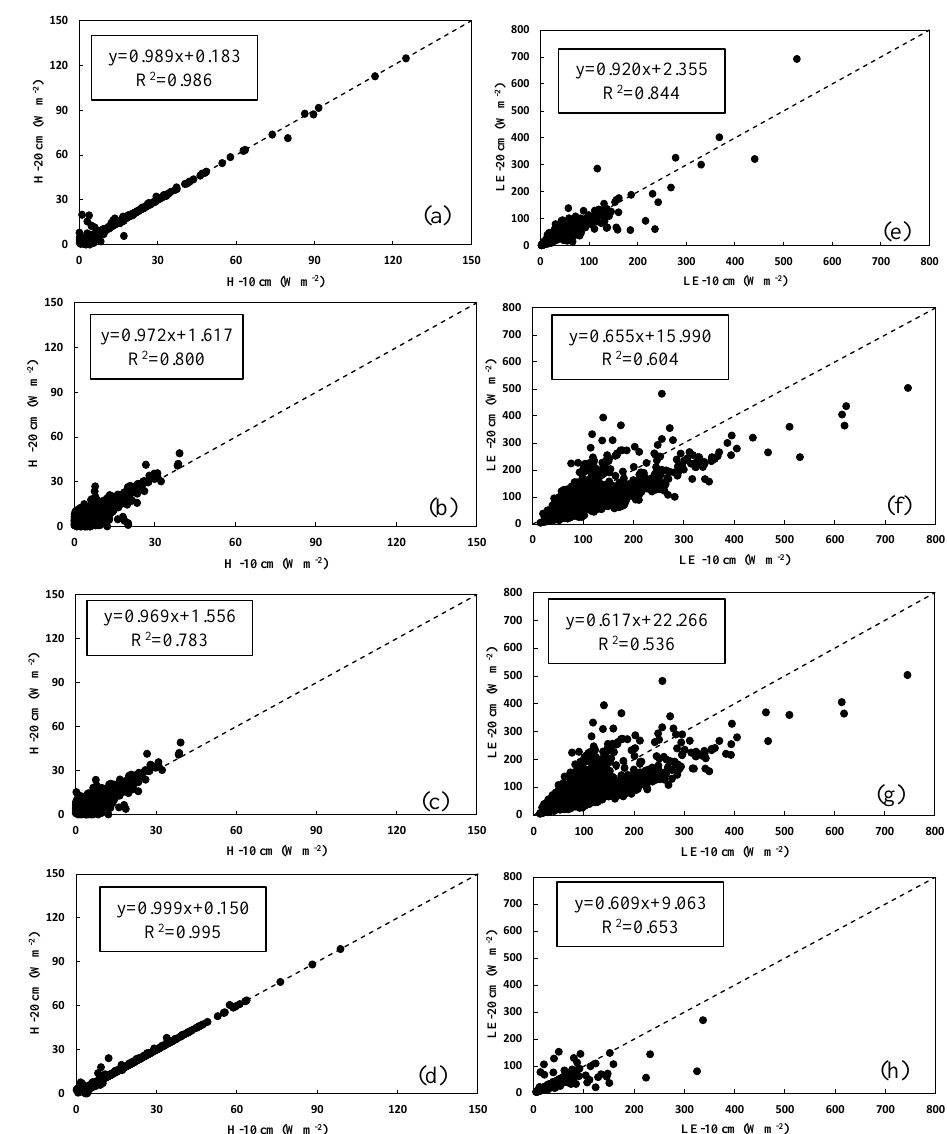
Figure 3. Comparison of the estimated results of H and LE between using water temperature at depths of 10cm and 20cm instead of lake water surface temperature in January and February, 2013 (a, e) , May and June, 2013 (b, f) , July and August, 2014 (c, g) , and November and December, 2012 (d, h) with the classical